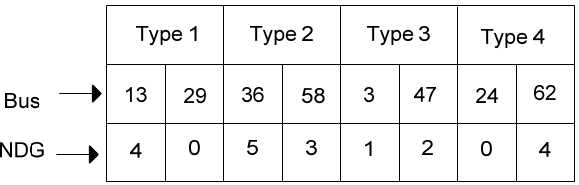
Figure 2. Exemplification of individual’s codification (chromosome).